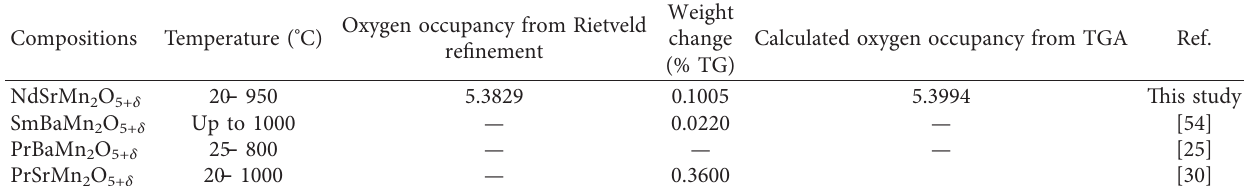
Table 4: Comparison of TGA results for NdSrMn 2 O 5+ δ and perovskite structures in the literature. Compositions